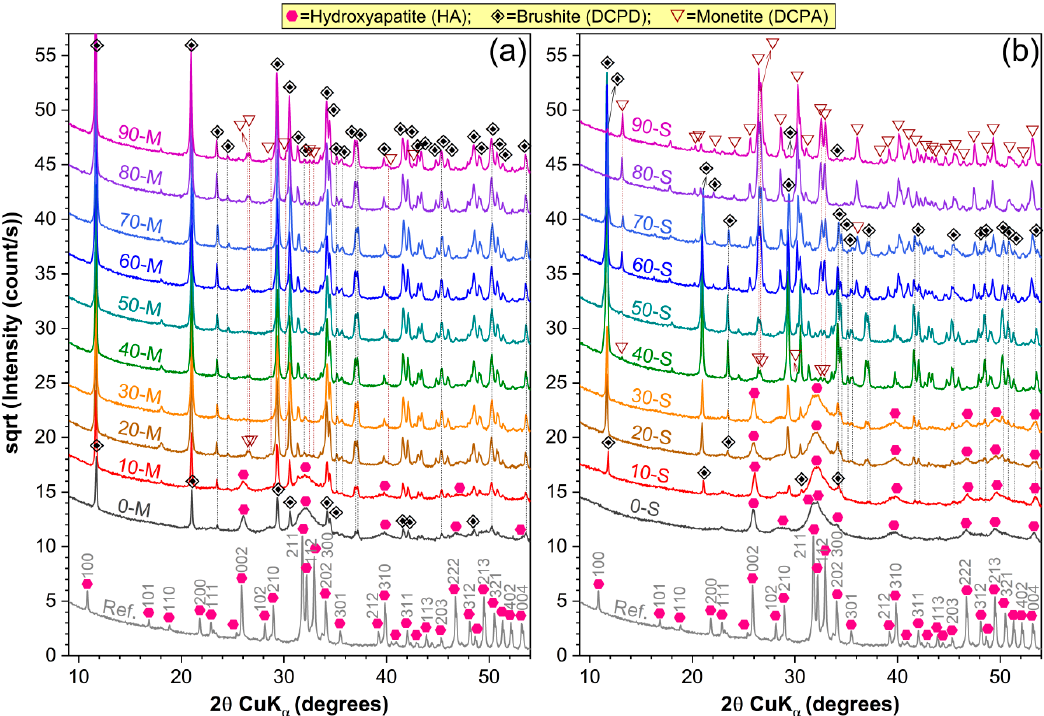
Figure 1. Comparative XRD patterns of the calcium phosphate powders synthesized using natural resources (i.e., ( a ) marble and ( b ) seashells) as calcium precursors and phosphoric acid amounts situated in the range 0–90%.